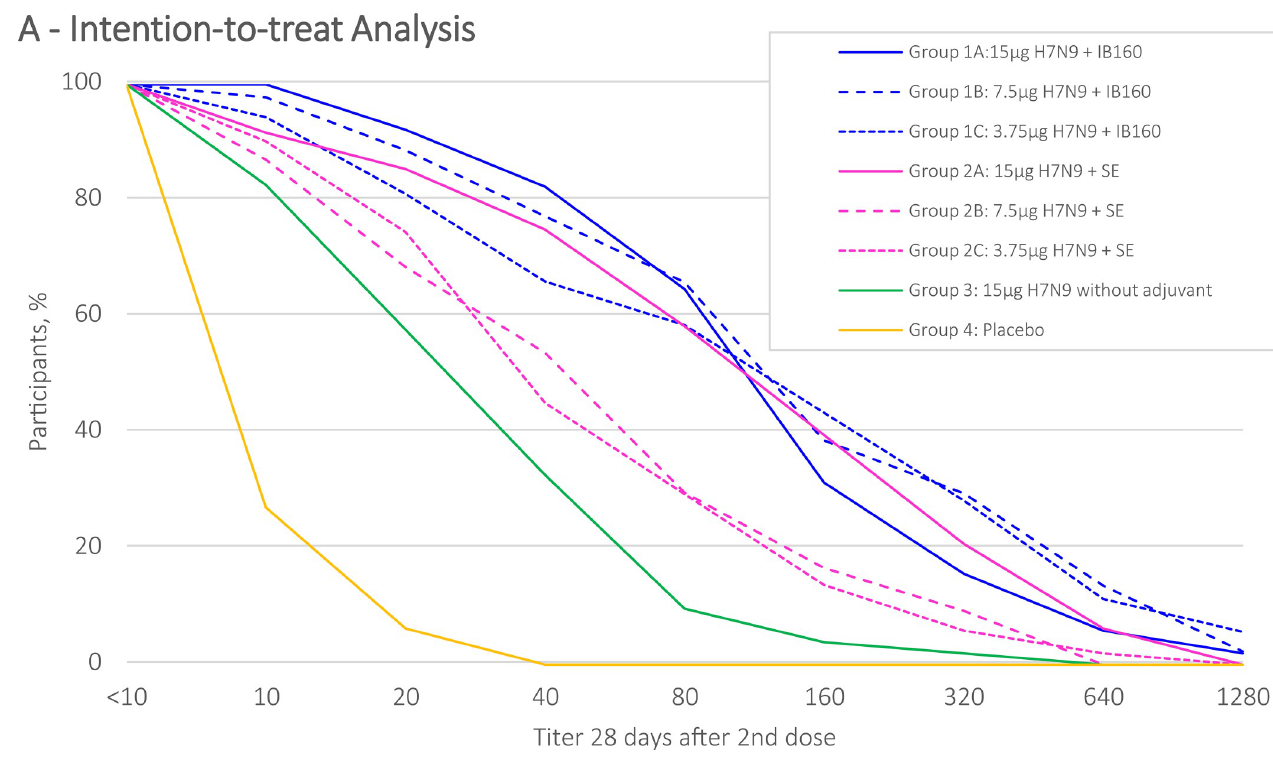
Fig 6. MNT antibody against H7N9 reverse cumulative distribution curve after 28(+7) days post 2nd dose administration, intention-to-treat.